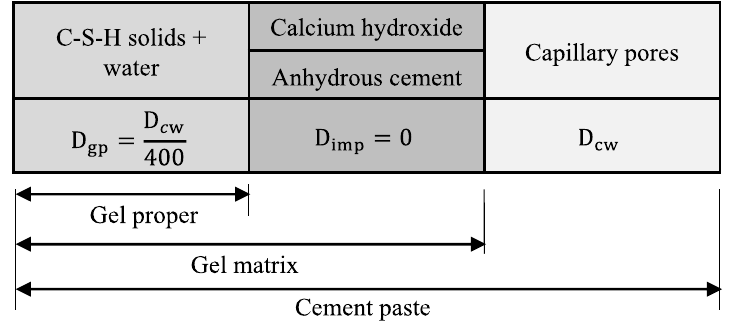
Figure 3. Diffusion coefficient for different components of cement paste.